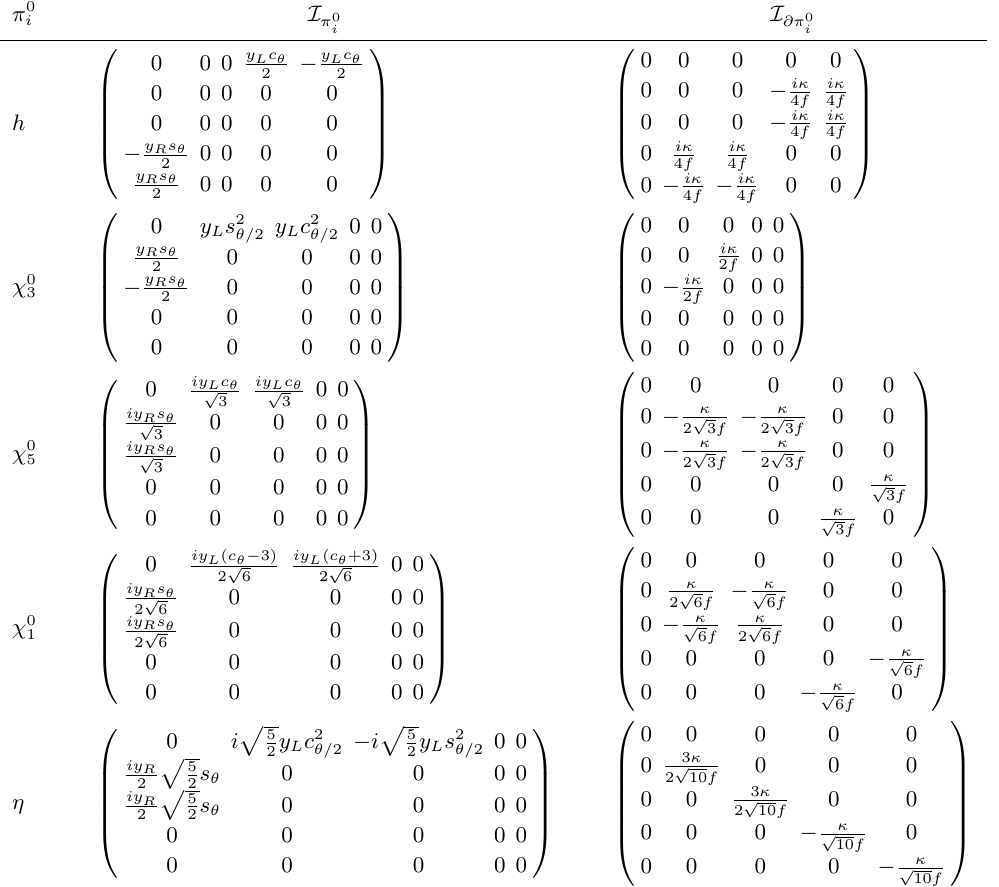
The expressions for the couplings to the neutral pNGBs, I π 0 ≡ h, χ 0 , χ 0 , χ 0 , η 3 5 1 i